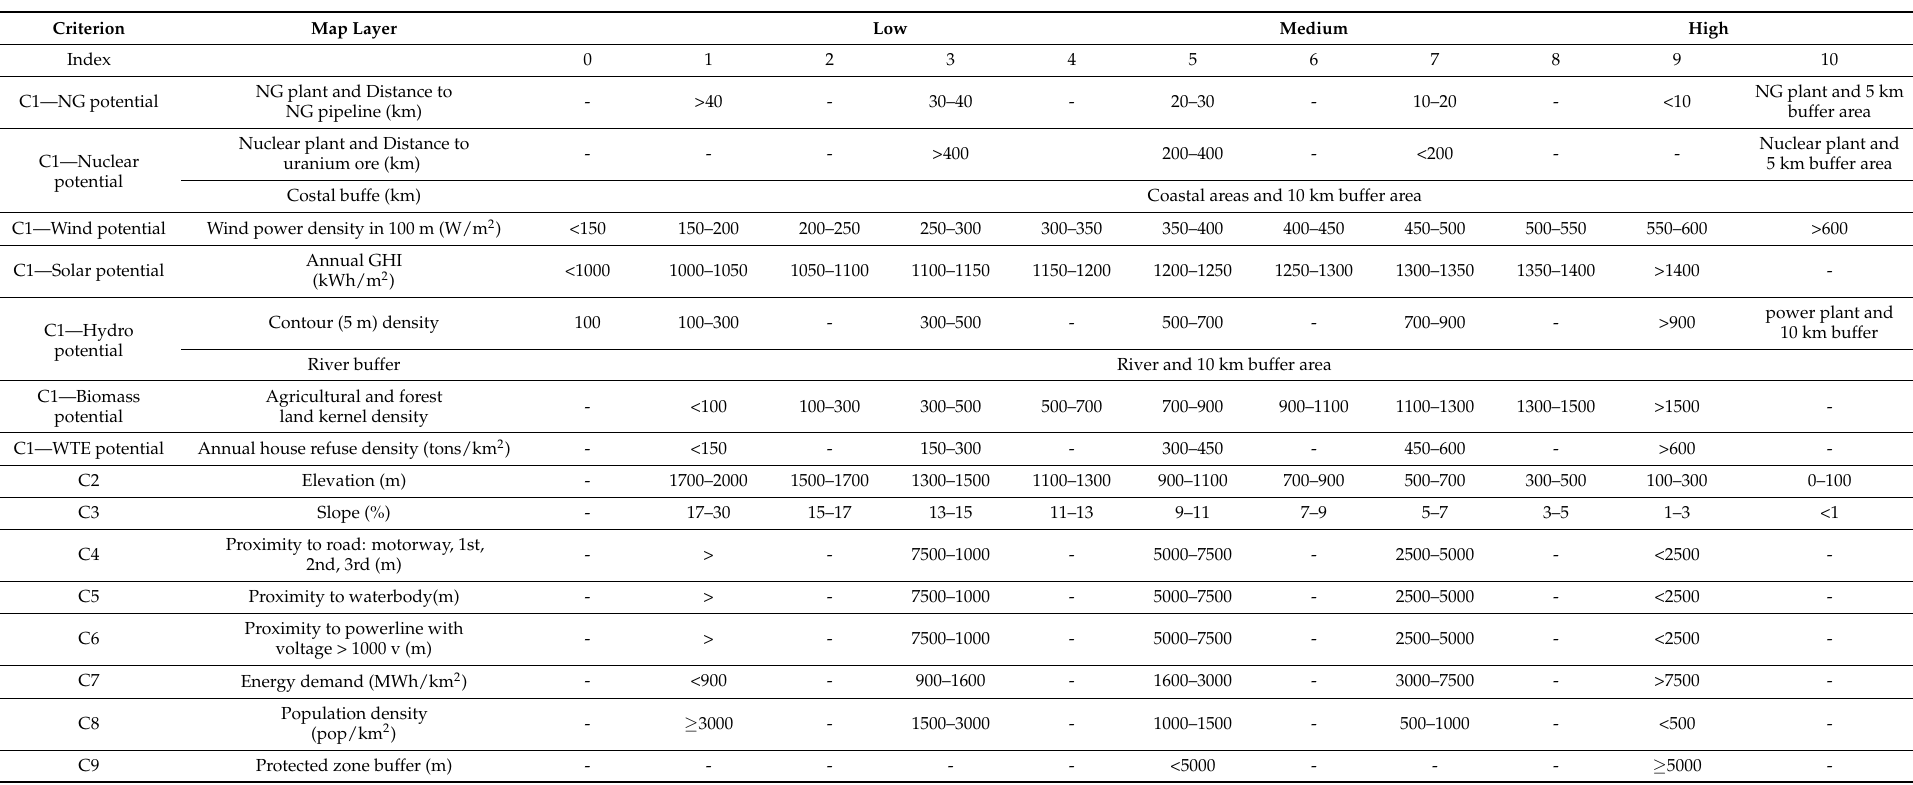
Table 2. Scoring scheme of criteria map